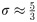
Interference depends on the choice of the scales.(a) Interference with rational scale ratio. Left: Representative posteriors (P(x|s)) for two modules with scale 1 and α = 3/2. Encoding becomes ambiguous at distance 3 from the origin where perfect interference occurs (3 = 2α). Right: Phase plot of the two modules, with the colour (red to blue) encoding the distance from the origin (see the coloured line below the left panel). Perfect interference occurs when the phase-curve overlaps with itself. (b) Interference with α = 1.76 …, which is close to 7/4 and therefore leads to strong interference at distance 7. Right: Interference occurs when the distance between two neighbouring segments of the phase curve becomes smaller than the limit set by the neuronal noise (grey squares of side δ around the origin, see inset). Note, that both grids are around phase 0.3 at the distance 2.3 without interference. (c) Interference with α = σ ≈ 1.618, which is the golden ratio. Interference still becomes stronger at larger distances, (e.g. at distance 5, since σ≈53). Interference in grid codes is related to the approximation of irrationals with rational numbers having small denominators (see text for further details). Right: Interference is inevitable since the phase space has a limited volume.